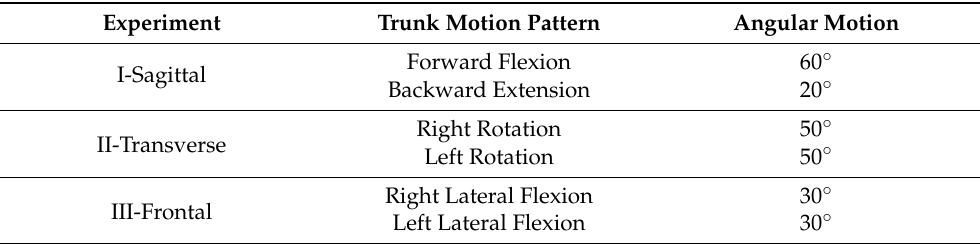
Table 1. The experiment designs.